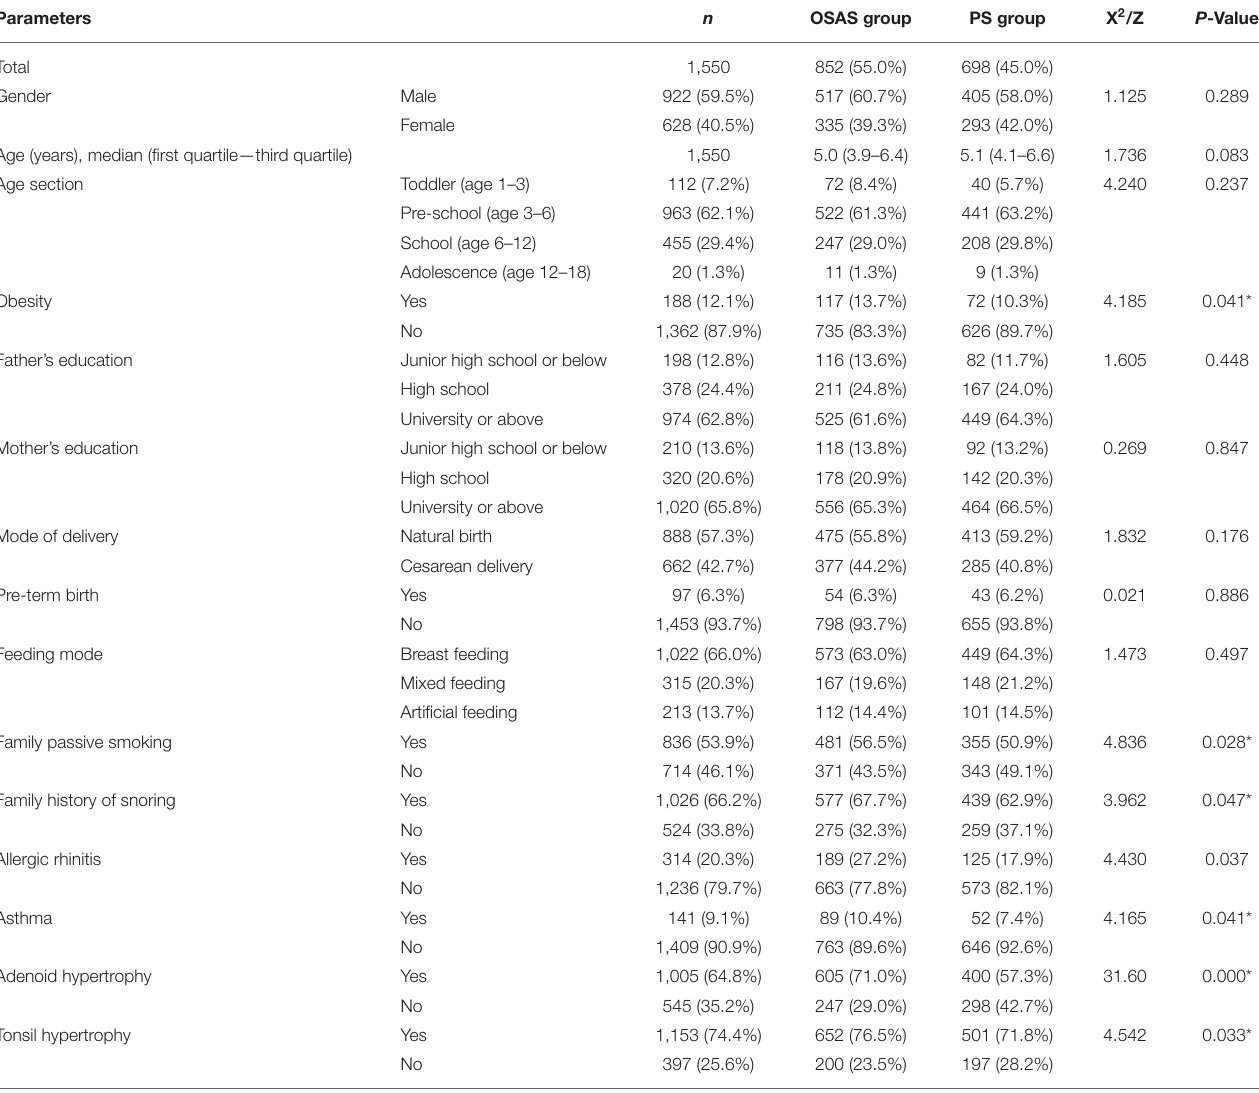
TABLE 1 | Patient characteristics in the OSAS and PS groups.